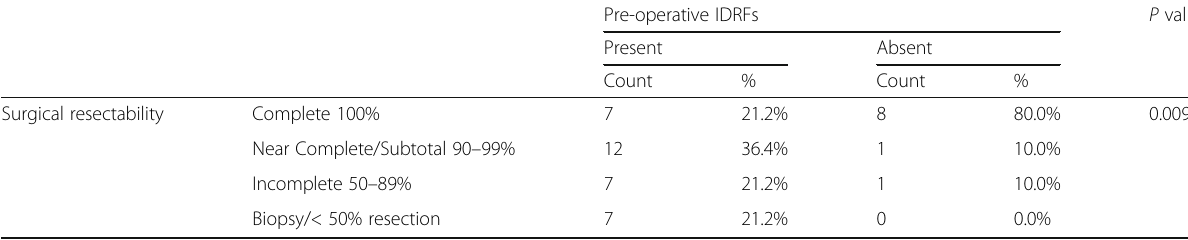
Table 4 Correlation between the pre-operative IDRFs and surgical resectability